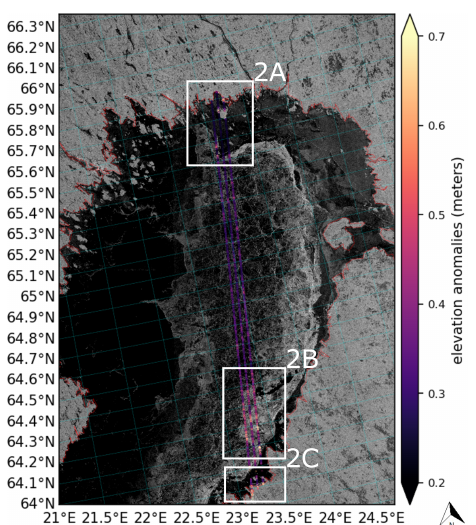
Figure 2. Elevation anomalies calculated using IS2 photons ac- quired 27 March 2019, overlaying S1 C-band (HV polarisation) SAR image acquired ∼ 0.45d (10h 35min) after IS2. Note the higher elevation anomalies acquired over more ridged ice (strong backscatter in white in SAR image). Areas mentioned in text are denoted